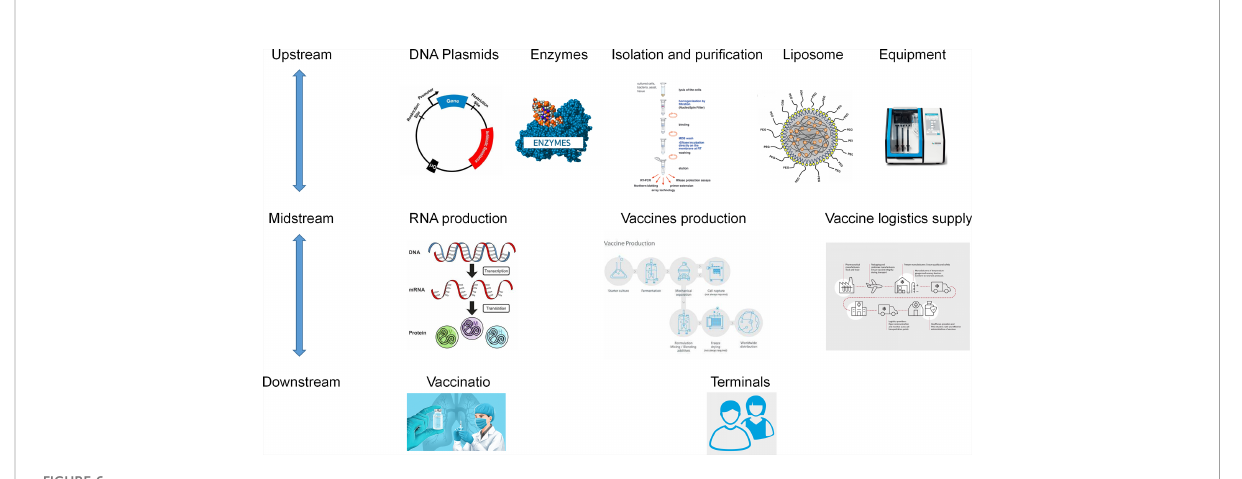
FIGURE 6 mRNA drugs industry